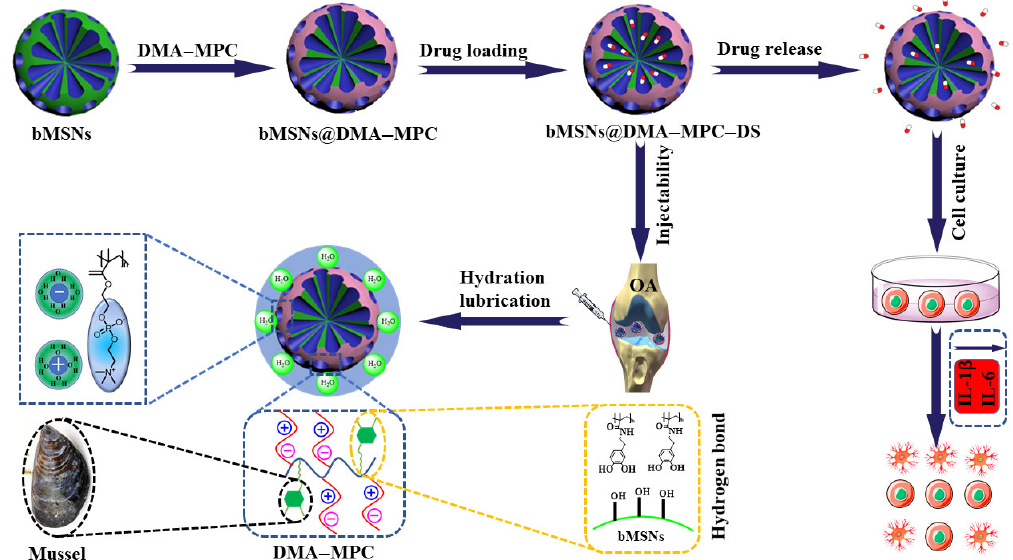
Fig. 1 Schematic image exhibiting the preparation of dual-functional nanoparticles of bMSNs@DMA–MPC–DS with improved lubrication and sustained drug release for early-stage osteoarthritis